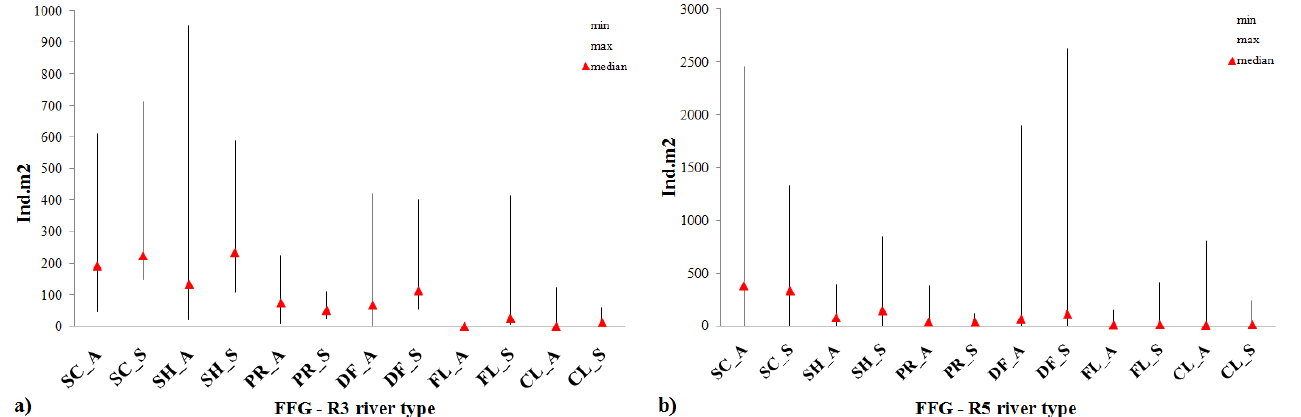
Figure 4. Total abundance of the trophic groups (min, max, median values) per season: ( a ) for the R3 sites and ( b ) for the R5 sites. For abbreviations, see Materials and Methods. Legend: A—autumn, S—spring.